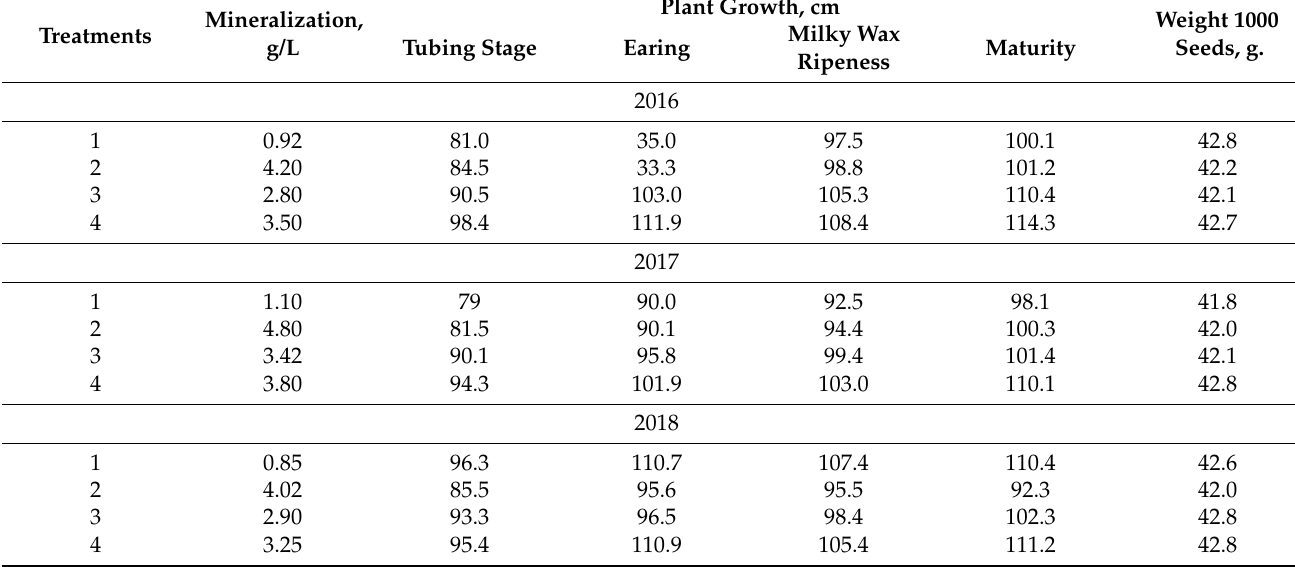
Table 5. Growth, development, and weight values of 1000 wheat